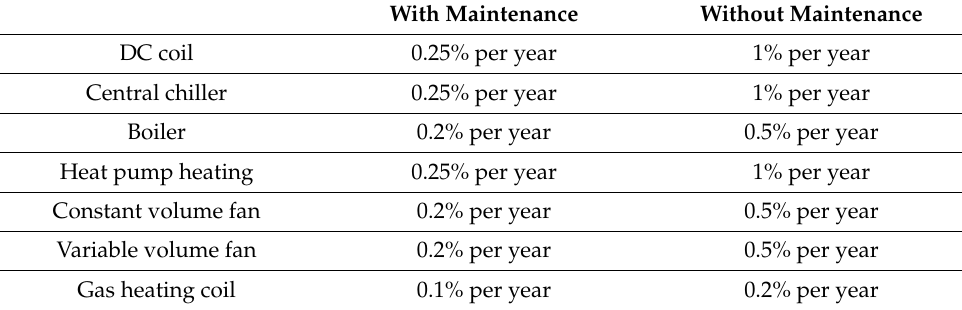
Table 1. Performance degradation of HVAC